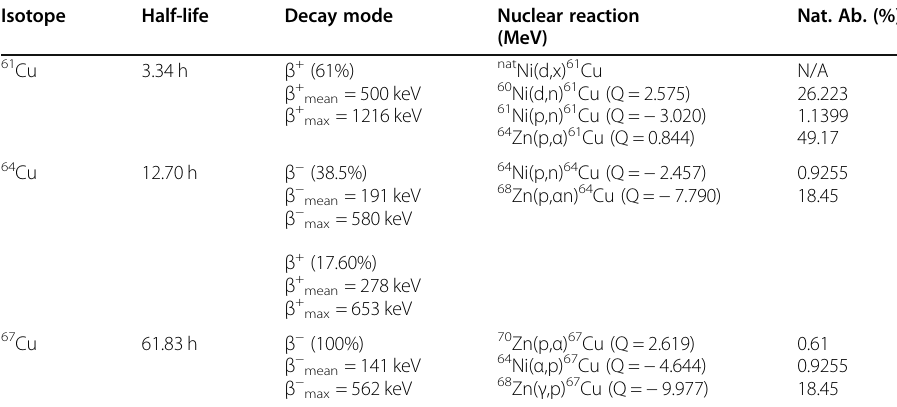
Table 1 Common production paths and decay properties of 61 Cu, 64 Cu and 67 Cu. All nuclear data was acquired from NuDat (Brookhaven National Laboratory 2020a) and Qcalc (Brookhaven